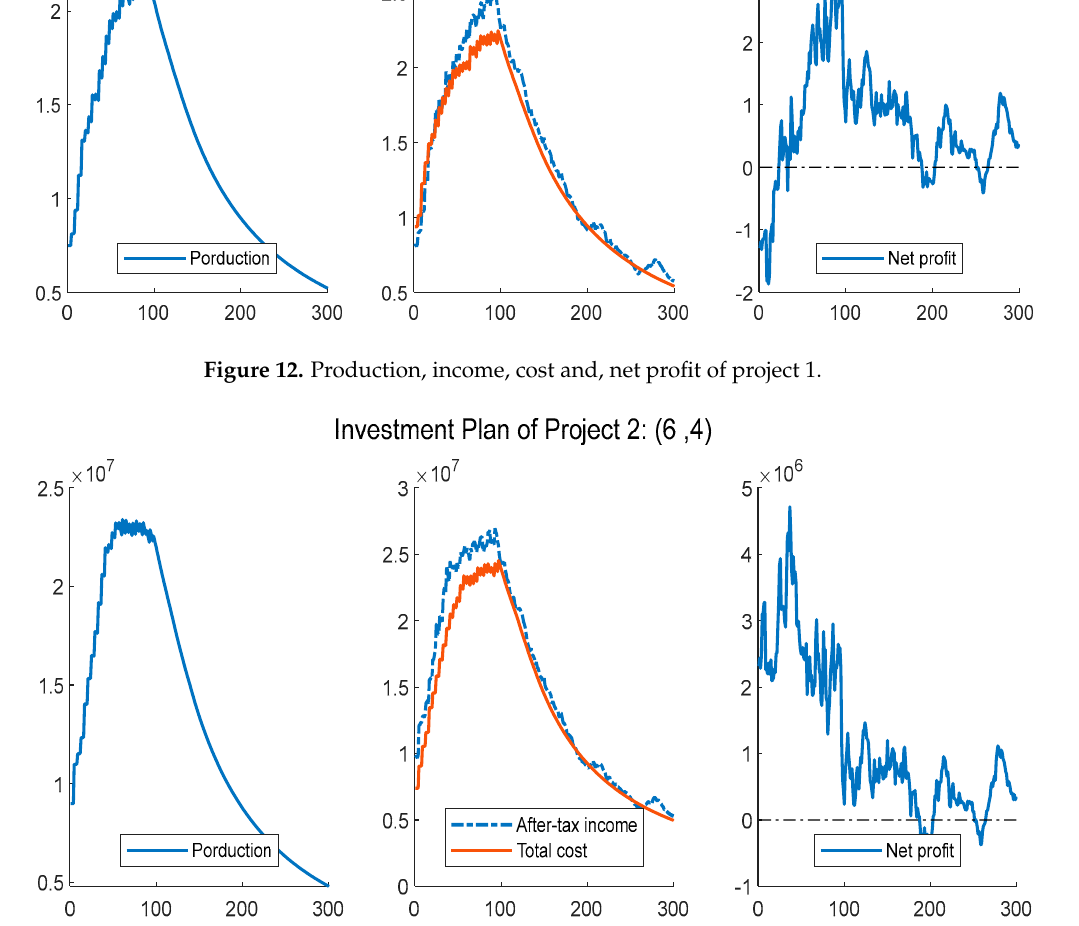
Figure 13. Production, income, cost and, net profit of project 2.